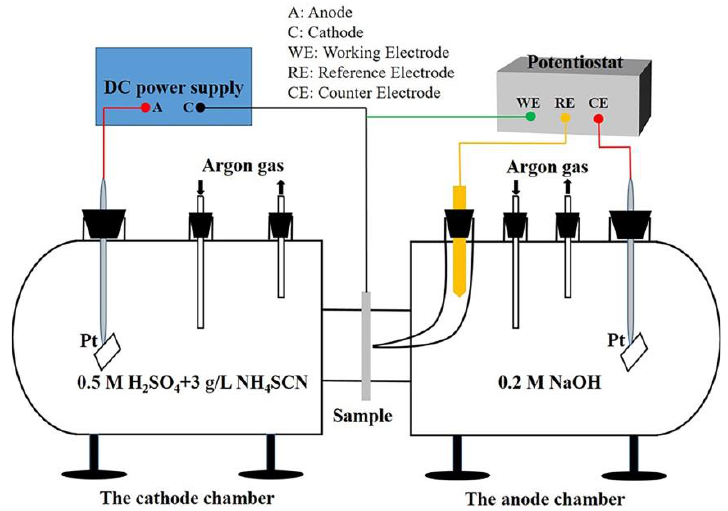
Figure 1. Devanathan – Stachurski cell for hydrogen permeation.